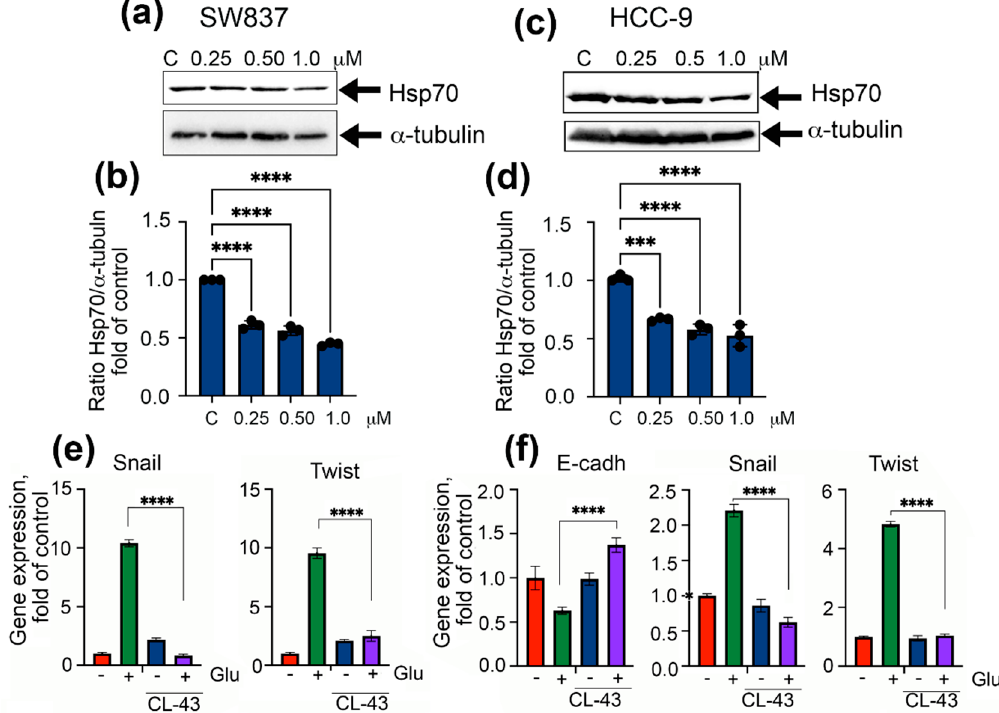
Figure 4. CL-43 is able to reduce expression of EMT markers in other colon cancer cell lines, including freshly isolated colon cancer cells from patients. ( a ) Western blotting of SW837 cells treated with 0.25, 0.5, and 1.0 µ M of CL-43 with antibody to Hsp70 and ( b ) ratio of intensity of Hsp70 bands to band intensity of a-tubulin. Band intensity was measured with the aid of ImageJ. Data of three western blots were calculated. **** p < 0.0001. ( c ) Western blotting of HCC-9 cells and ( d ) ratio of intensity of Hsp70 bands to band intensity of a-tubulin. *** p = 0002, **** p < 0.0001. ( e ) Snail and Twist expression in SW837 cells after 7 days of incubation with 500 nM CL-43 and 80 mM glucose. **** p < 0.0001. ( f ) E-cadherin, Snail, and Twist expression in HCC-9 cells cultured in the presence of 500 nM CL-43 and 80 mM glucose. **** p < 0.0001.